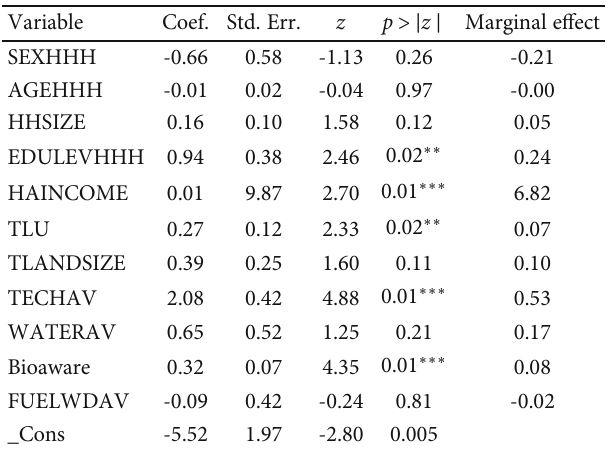
Table 6: Results of binary probit estimation for the determinant factors of biogas technology